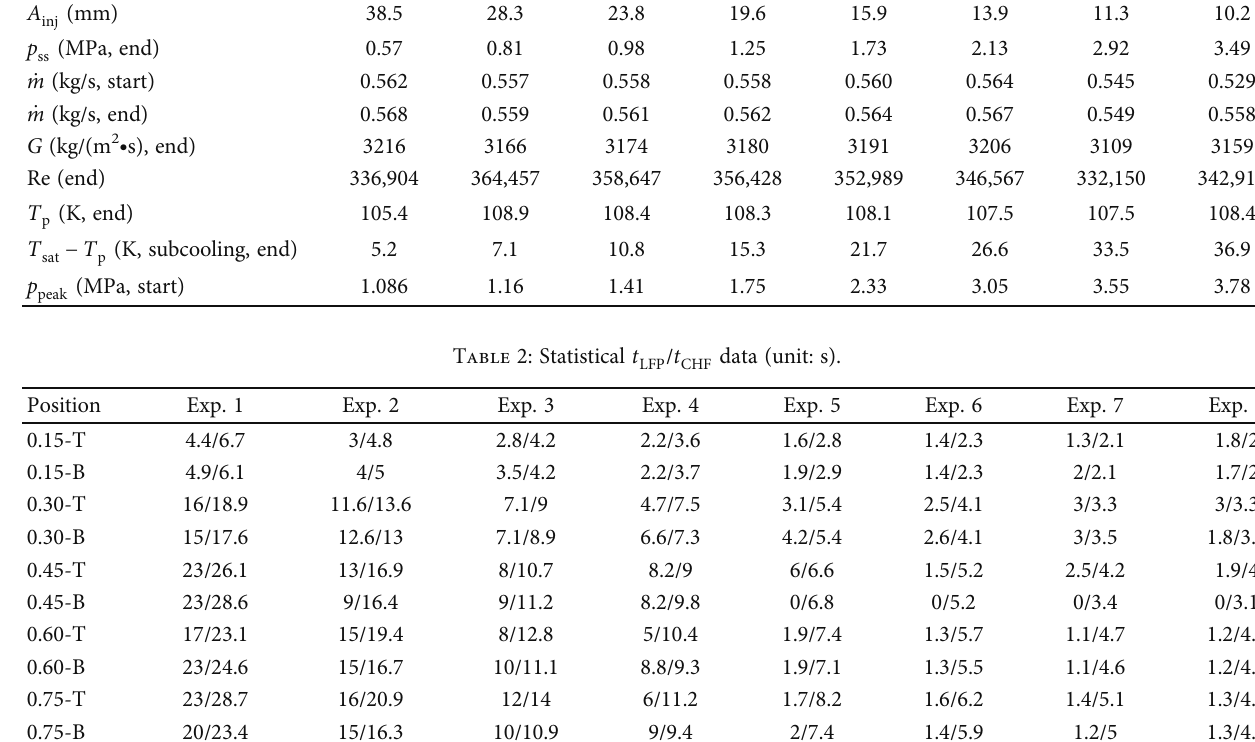
Table 1: Experimental conditions and results.